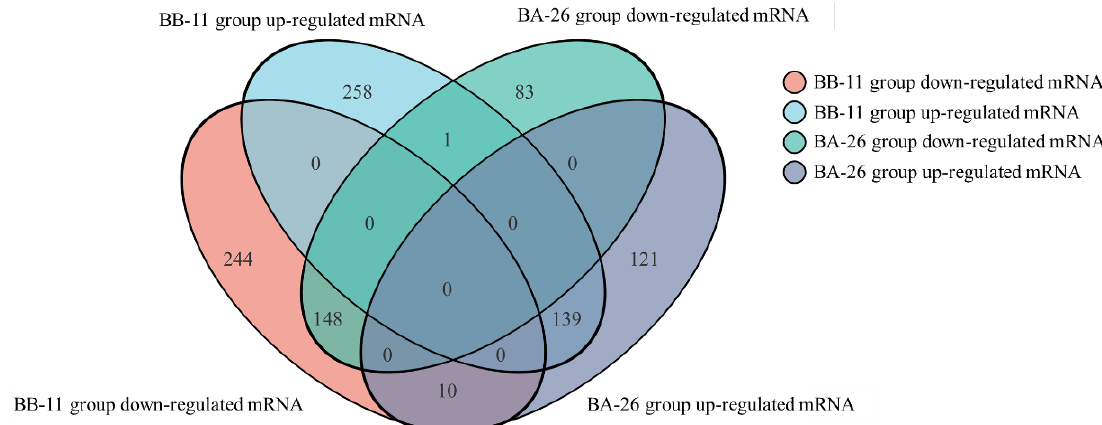
Figure 5. Distribution of differentially expressed genes (DEGs) between samples. DEGs were analyzed with the DEseq2 method, and DEGs were defined based on the following criteria: |log2 (fold change)| ≥ 1.00 and an adjusted p value ≤ 0.05.